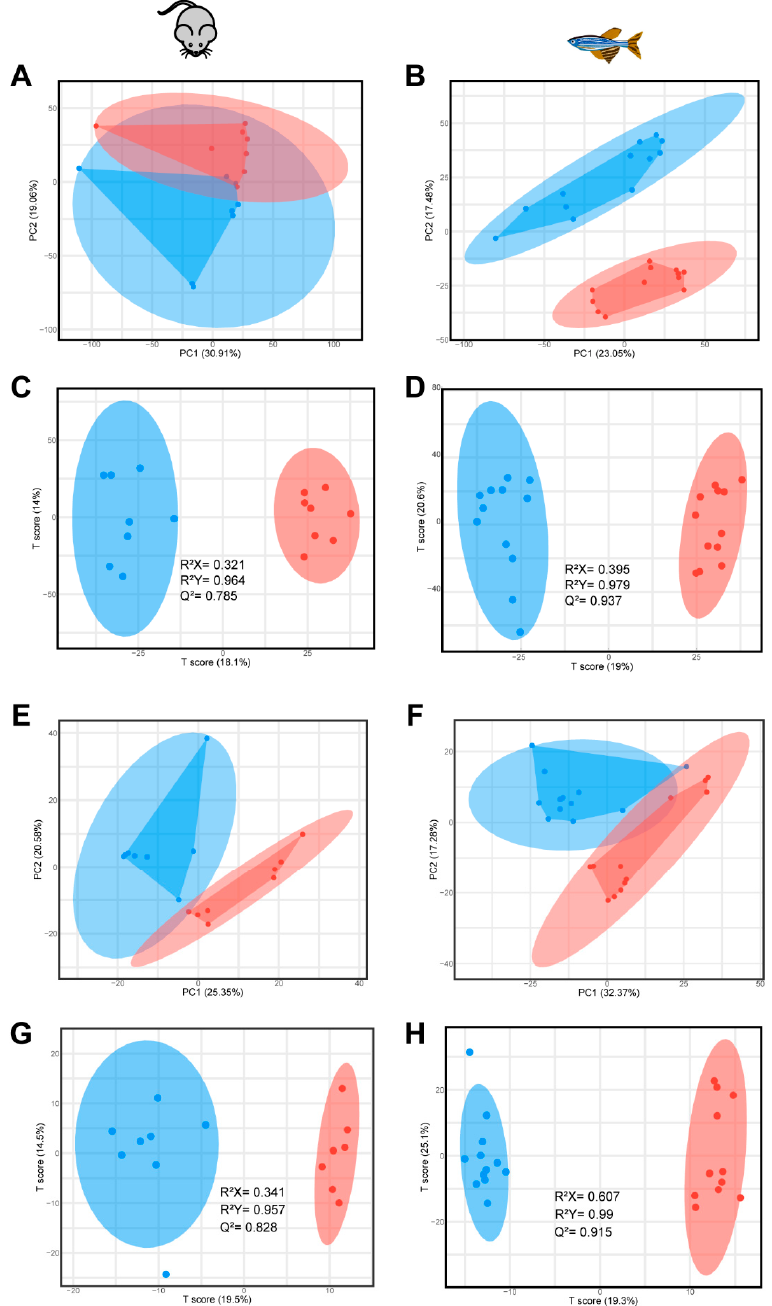
Figure 3. The PCA and OPLS-DA score plots of each model. ( A ) The PCA score plot of CUMS in mice. ( B ) The PCA score plot of CUMS in zebrafish. ( C ) The OPLS-DA score plot of CUMS in mice. ( D ) The OPLS-DA score plot of CUMS in zebrafish. ( E ) The PCA score plot of reserpine in mice. ( F ) The PCA score plot of reserpine in zebrafish. ( G ) The OPLS-DA score plot of reserpine in mice. ( H ) The OPLS-DA score plot of reserpine in zebrafish. Blue represents Control group, red represents model